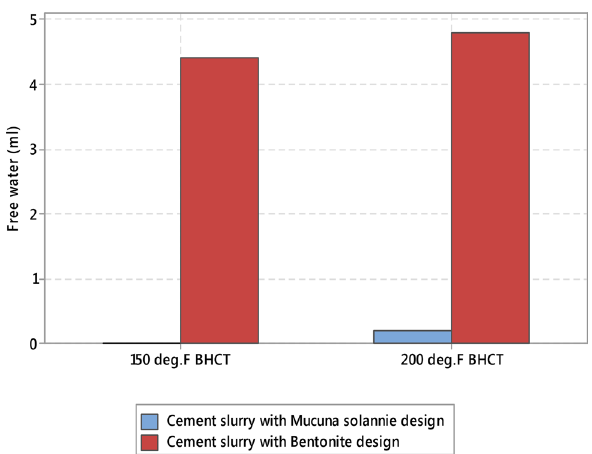
Fig. 16 Cement slurry free water properties obtained from Mucuna solannie and